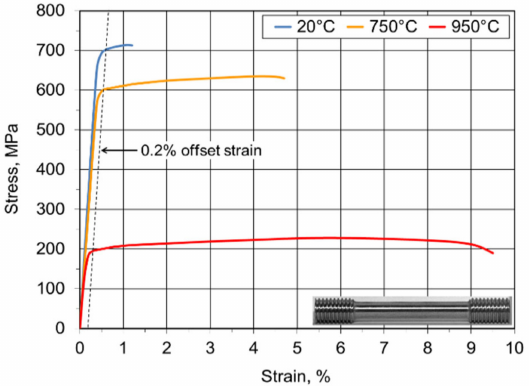
Figure 9. Stress vs. strain representative curves of the Ti-45Al-8Nb-0.5(B,C) alloy obtained at room and elevated temperatures by means of static tensile